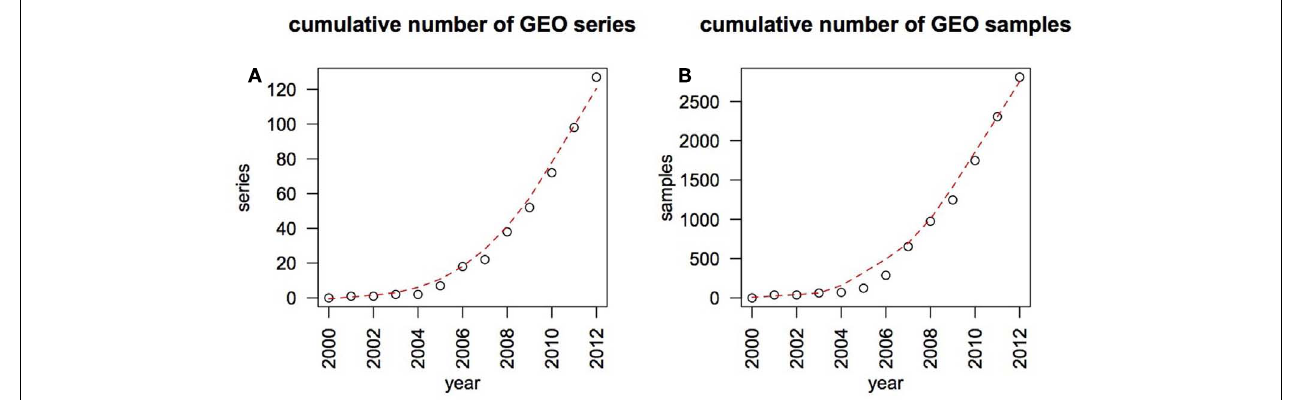
2819 samples that match these search criteria.The cumulative number of data series (submitted experiments) (A) and individual samples (B) are plotted as black circles, overlaid by a red trend line fitted over this data using the loess